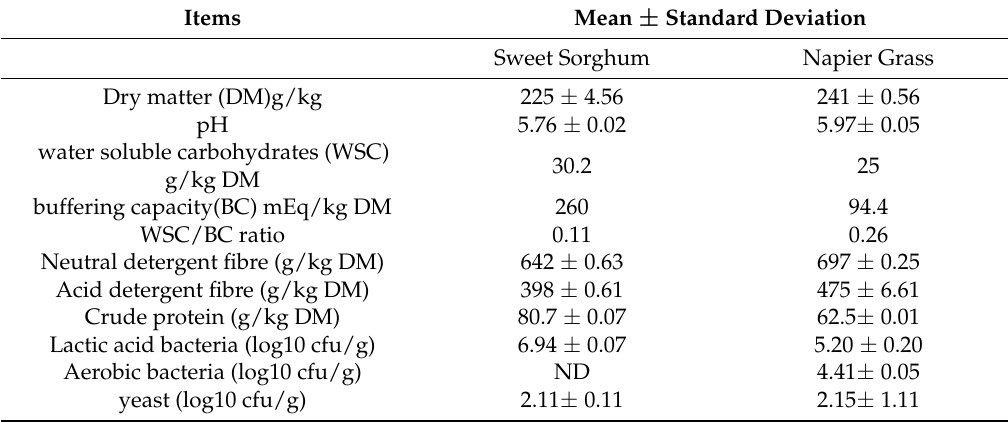
Table 1. Chemical composition and microbial analysis for fresh sweet sorghum and Napier grass.